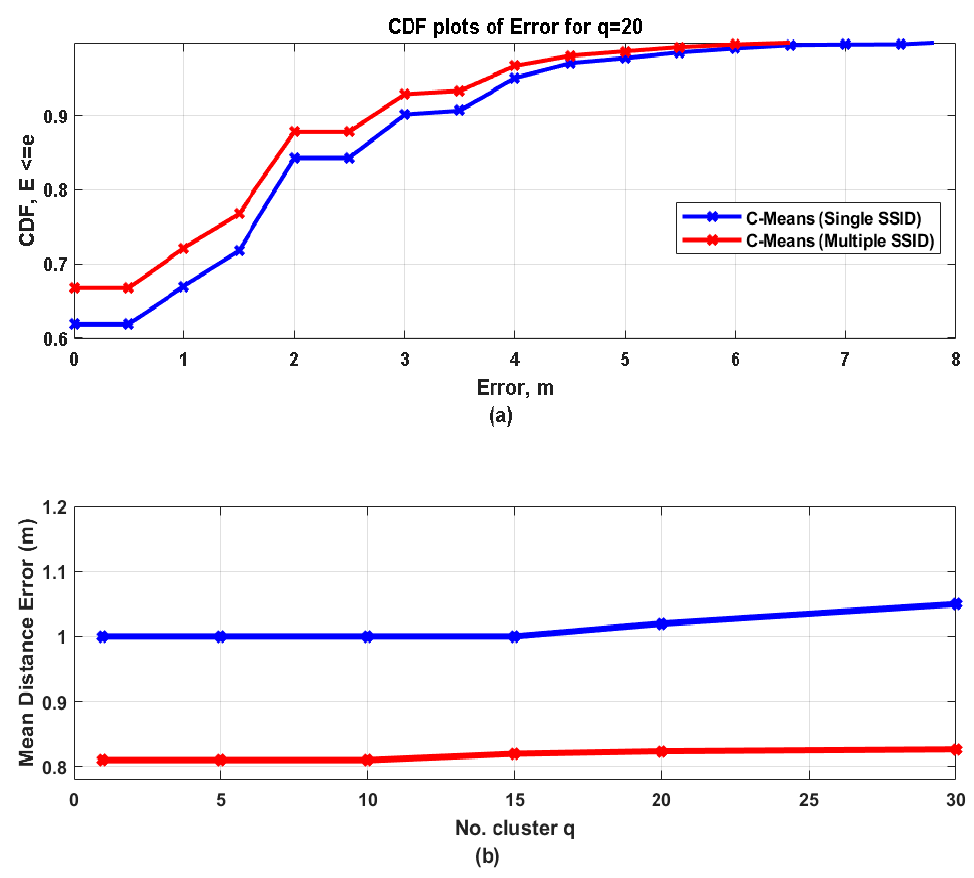
Figure 14. Fuzzy C-means clustering. ( a ) CDF of Error; ( b ) mean error versus number of clusters.